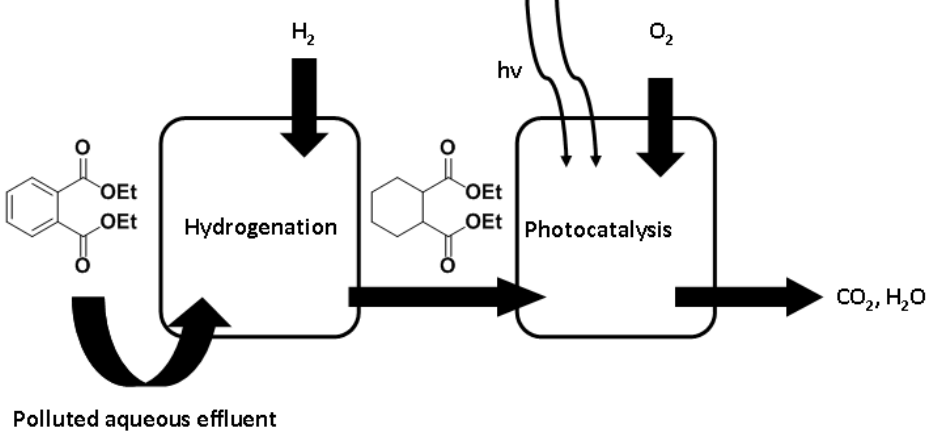
Figure 1. Removal of diethyl phthalate (DEP) through a pertinent “domino” process .